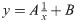
Properties of subthreshold (sLFP).
A. Spatial layout of stimulus configuration: the cross marks the central fixation target; dashed white circle represents the RF (1.6° in diameter, centered at 0.6° right and 4.1° down); a Gabor stimulus at the RF and three identical stimuli positioned outside the RF spaced at intervals of one RF diameter away from the RF along the direction collinear to preferred orientation (a, b, and c); the calibration bar indicates 1°. The distance of stimuli at a, b, and c from the RF center in cortical dimension was estimated to be 3.28, 5.89, and 8.06 mm, respectively. B, C. Raster and spike density plots (B) and mean LFP traces (C). Shading in C indicates ±2 SE. From top to bottom, responses to the Gabor stimulus at the RF alone, and those at a, b, and c alone are shown, aligned at the stimulus onset times (vertical lines). Note that a robust LFP change was evoked by the stimuli at a, b, and c, while the spike activity remained unchanged. The dominant positive and negative peaks of this sLFP are indicated as ‘p’ and ‘n’, respectively. D. Power (RMS) of sLFP as a function of cortical distance between the center of Gabor stimulus in the RF surround and the center of RF, extracted from data on 56 surround stimuli tested at 40 cortical sites. The curve is a fitted function in the form of y=A1x+B, following the inverse distance law of sound pressure, where x is cortical distance in mm between the center of Gabor stimulus in the RF surround and the center of RF. Parameter A was estimated to be 0.21, and its 95% confidence limits were 0.10 and 0.31; B was estimated to be 0.00. E. The amplitude of the sLFP, as measured from positive to negative peaks (as shown in C) as a function of cortical distance between the center of Gabor stimulus in the RF surround and the center of RF for 52 conditions. Four of the 56 conditions in D, for which the peaks could not be determined, were excluded. The curve is a fitted function in the same form as in D. Parameter A was estimated to be 0.67, its 95% confidence limits were 0.27 and 1.07; B was estimated to be 0.02. F, G. Latency to positive (open squares) and negative (dots) peaks of sLFP as a function of cortical distance between the center of Gabor stimulus in the RF surround and that at the center of RF, separately for monkey IR (F) and monkey CR (G) from the 52 conditions shown in E. The data were separately fitted with linear regression equations: y = 4.83x+54.79 and y = 3.90x+134.46 for monkey IR, and y = 3.27x+73.90 and y = 2.71x+147.44 for monkey CR, for latency to the positive and negative peak, respectively, where x is cortical distance between the two stimuli (p<0.05 for all cases).